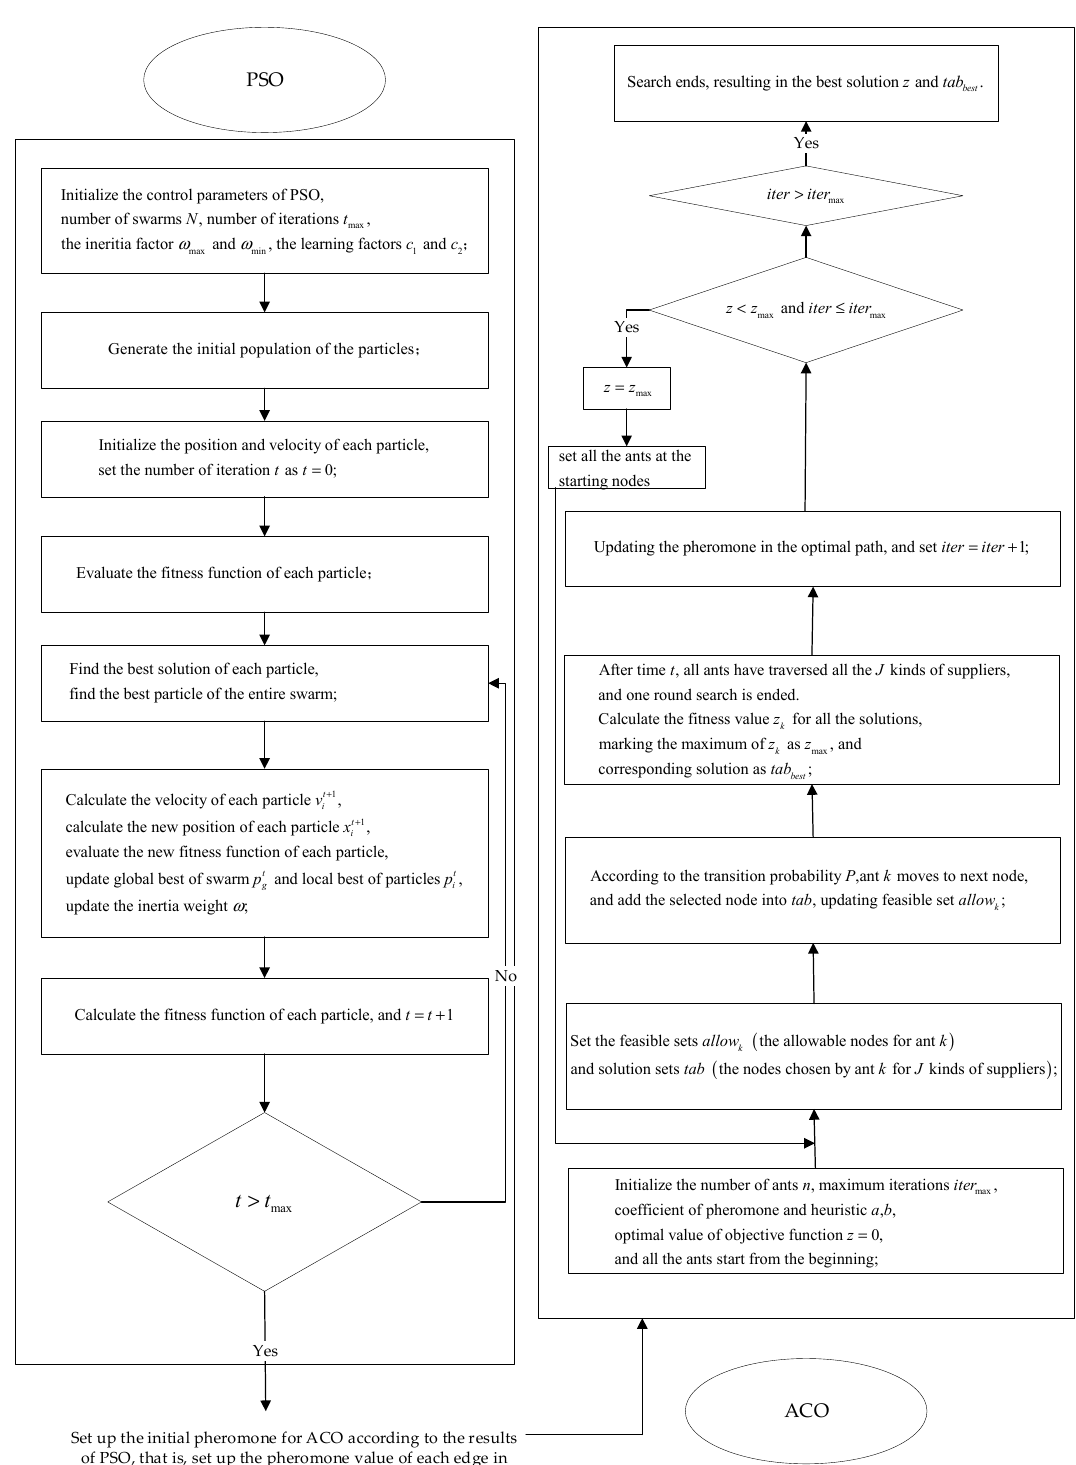
Figure 5. The process of PSACO.